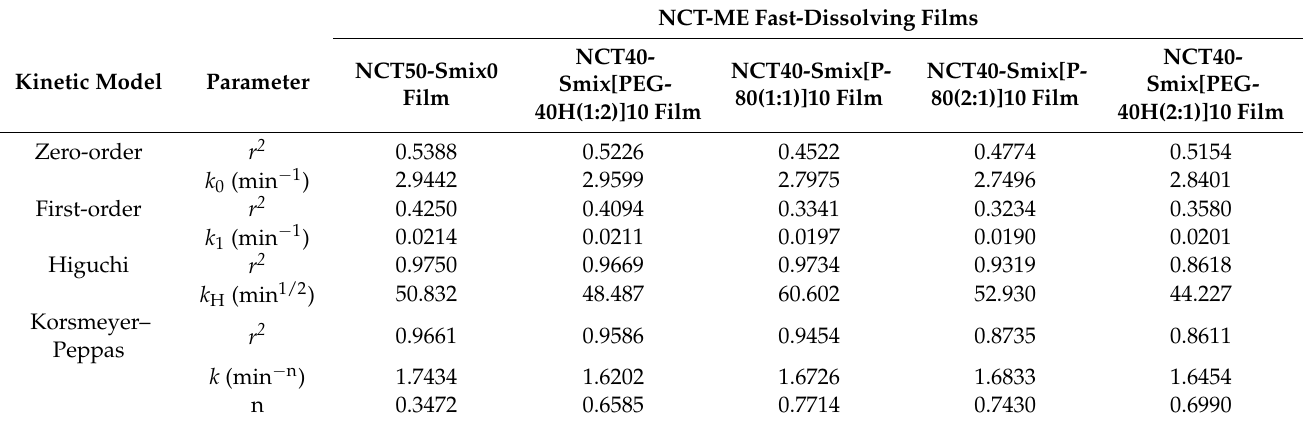
Table 4. Release kinetic data of NCT-ME fast-dissolving films using various kinetic